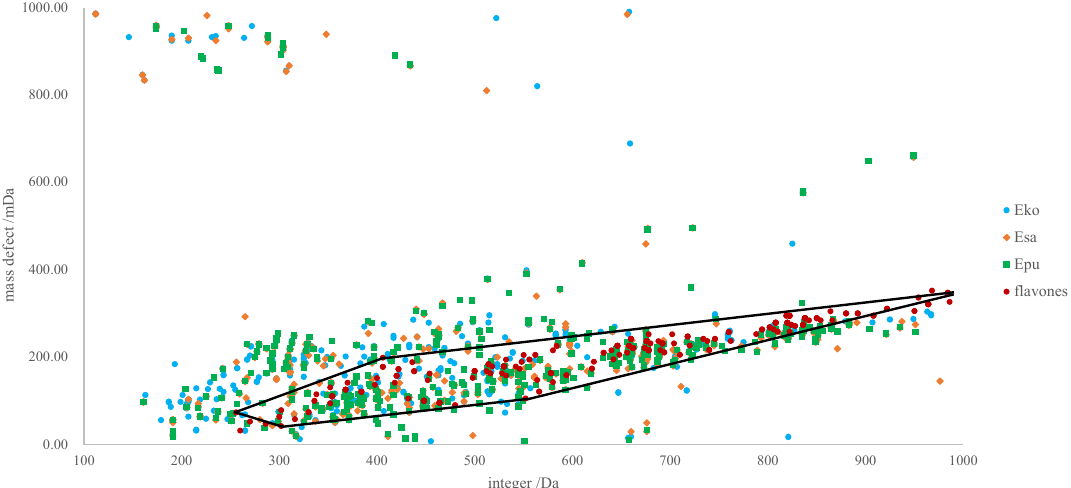
Figure 2. Integer parts against decimal parts of the compounds in the in-house chemical library (red solid dots) and the detected MS 1 signals (orange diamonds for Esa, blue solid dots triangles for Eko, and green square for Epu). A five-point frame was drawn to involve all red solid dots, and only those dots in the frame were the potential flavonoids in Epimedium plants.